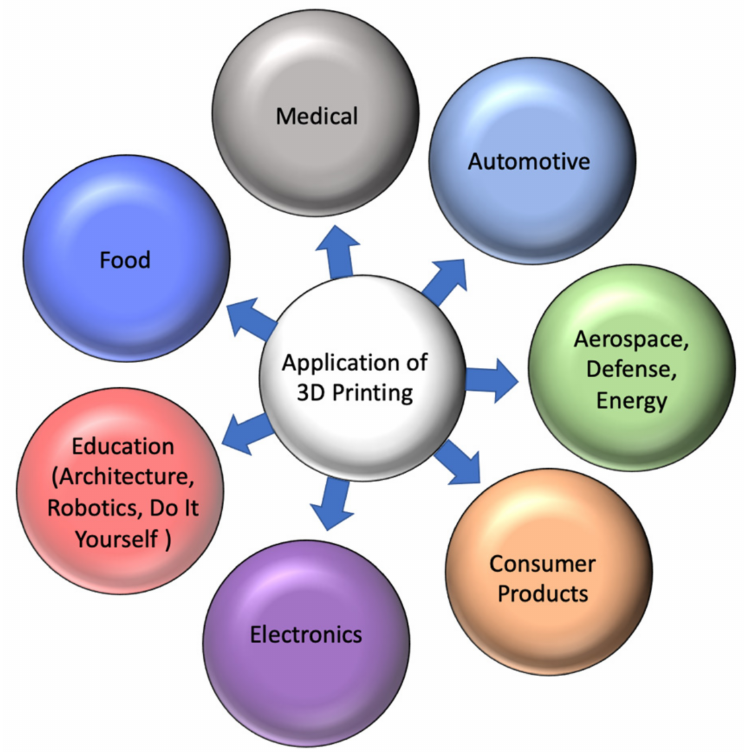
Figure 12. Typical current and possible future application of 3D printing